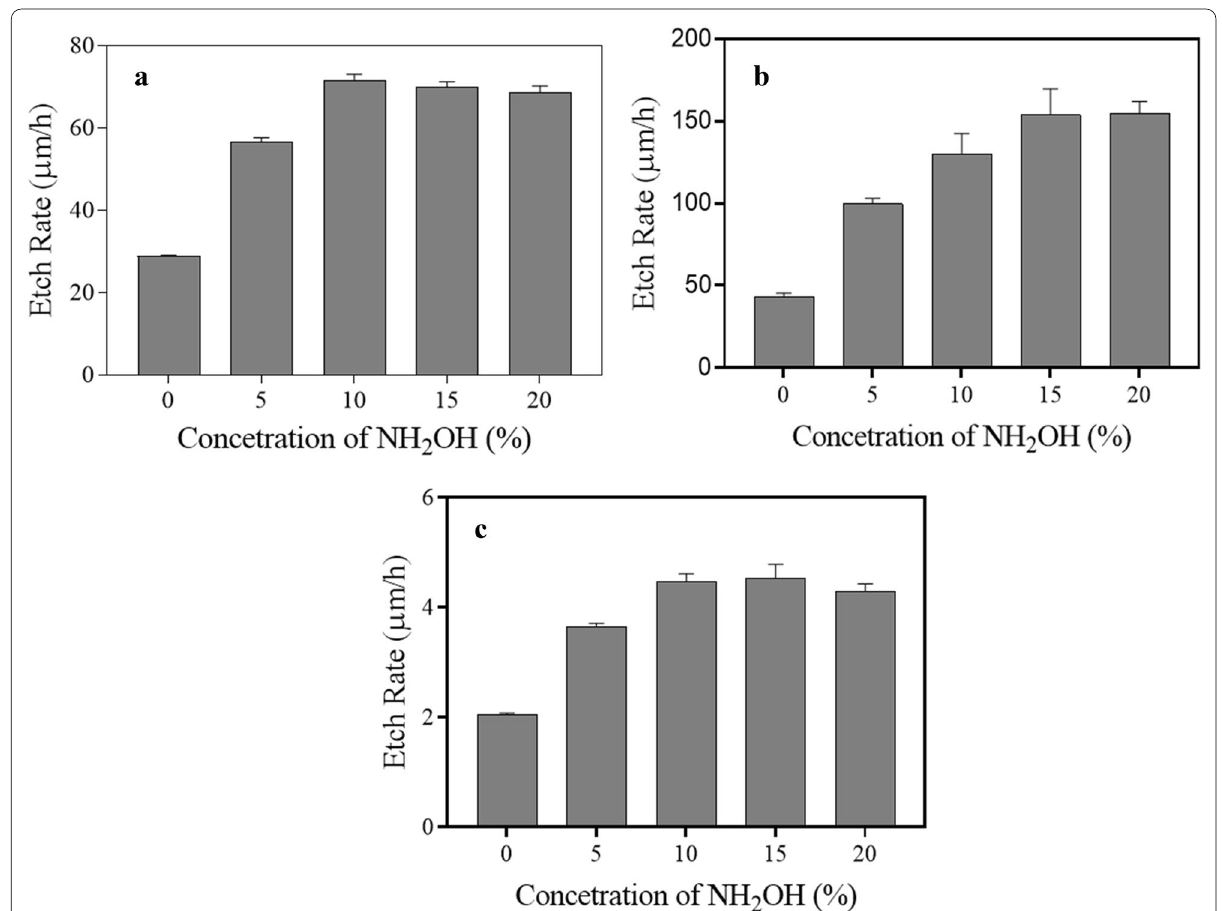
Fig. 28 Etch rates of a Si{100} b Si{110} and c Si{111} in 5 wt% TMAH without and with varying concentrations of NH 2 OH at 70